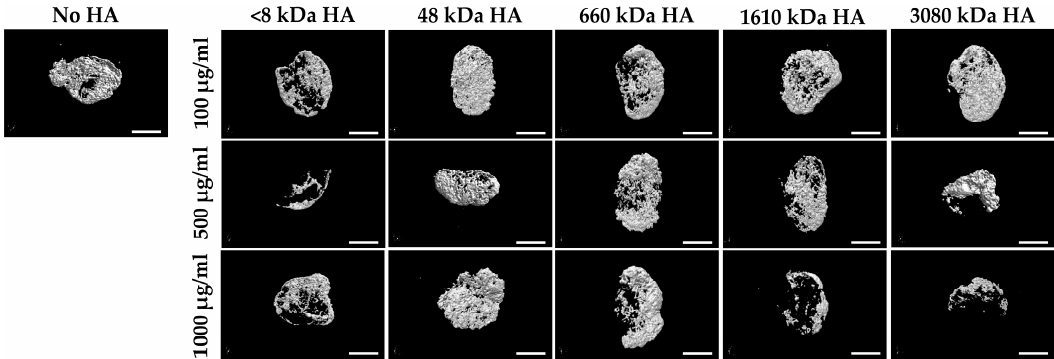
Figure 1. Micro CT images of BMP-2/ACS constructs (10 µ g BMP-2 per sample) in the presence or absence of 100, 500, or 1000 µ g/mL HA with different polymer sizes (<8, 48, 660, 1610, 3080 (kDa)) at 18 days after implant placement (Bar = 2.5 mm).